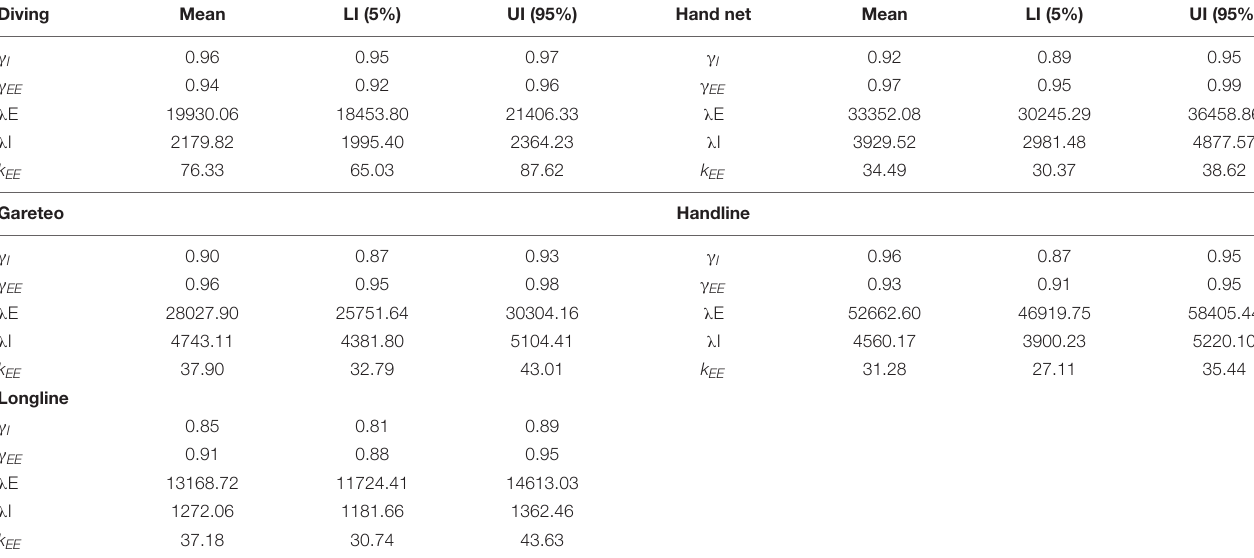
TABLE 2 | Mean estimate values for five parameters of the CCRW model. Diving Mean Hand net